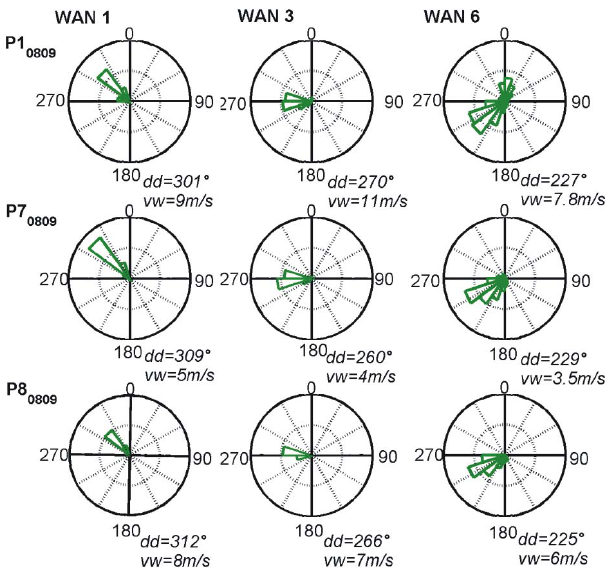
Fig. 3. Wind roses for the permanent weather stations WAN 1, WAN 3 and WAN 6 for the three NW storms P1 0809 , P7 0809 and P8 0809 . dd stands for the mean wind direction and vw for the mean wind velocity of the entire